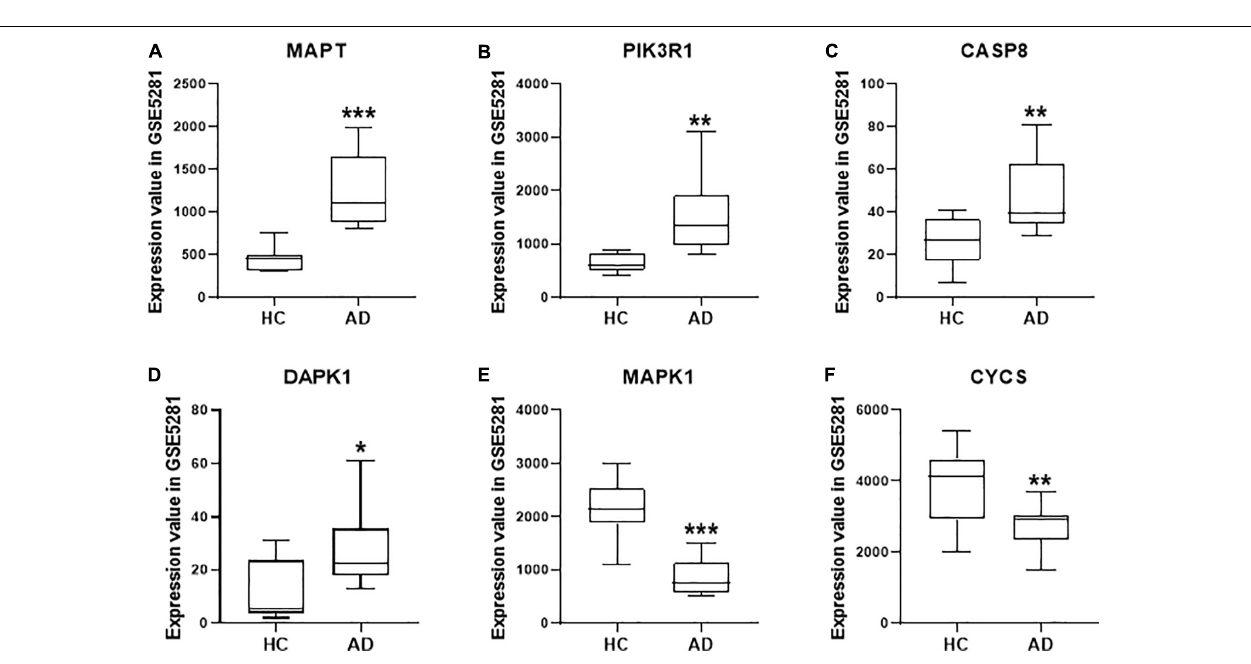
FIGURE 7 | The quercetin target gene expression in HC and AD groups of GSE5281 dataset. The expression of MAPT (A) , PIK3R1 (B) , CASP8 (C) , DAPK1 (D) , MAPK1 (E) , and CYCS (F) in different groups. Values are presented mean ± SEM ( n = 10 in each group). ∗ p < 0.05, ∗∗ p < 0.01, ∗∗∗ p < 0.001 vs. HC group.